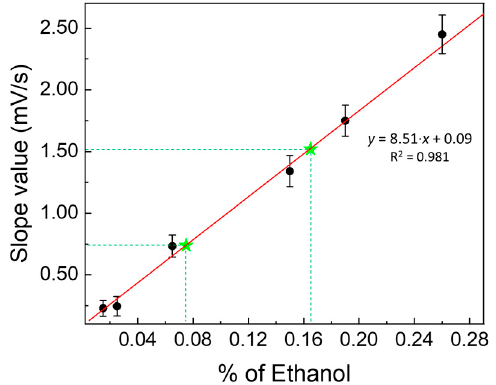
Figure 8. Calibration curves used for ethanol determination in human saliva samples. Calibration curve obtained by «kinetic methods» (slope values vs. increasing percentage of ethanol), using the enzymatic fuel cell modified by catalase, crosslinked with LDHs (1:1.5 by weight) and H 2 O 2 (12 mmol L − 1 ) in solution, in the hydroalcoholic solutions tested. Green stars represent the percentage of ethanol found in biological samples (saliva).